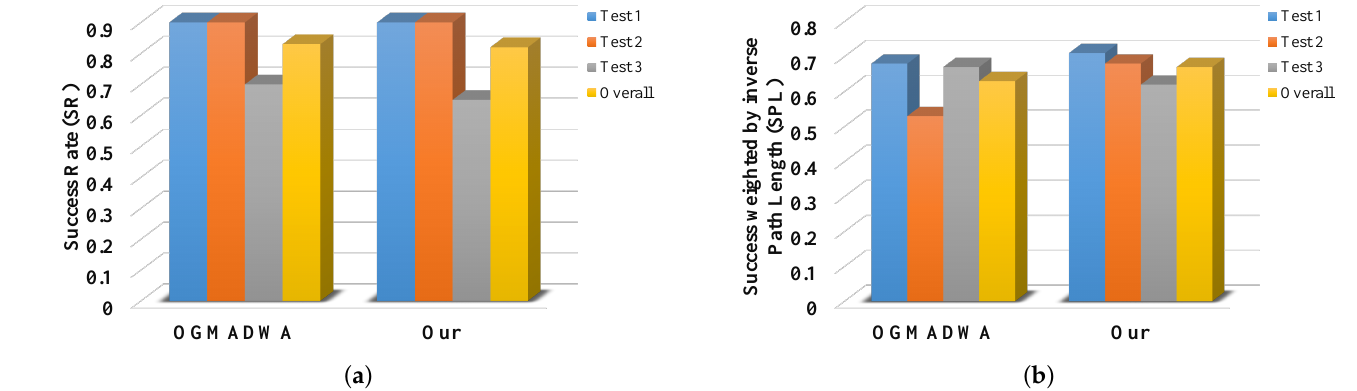
Figure 21. SRs and SPLs result for OGMADWA and our method on real-world datasets. ( a ) Results of SRs; ( b ) Results of